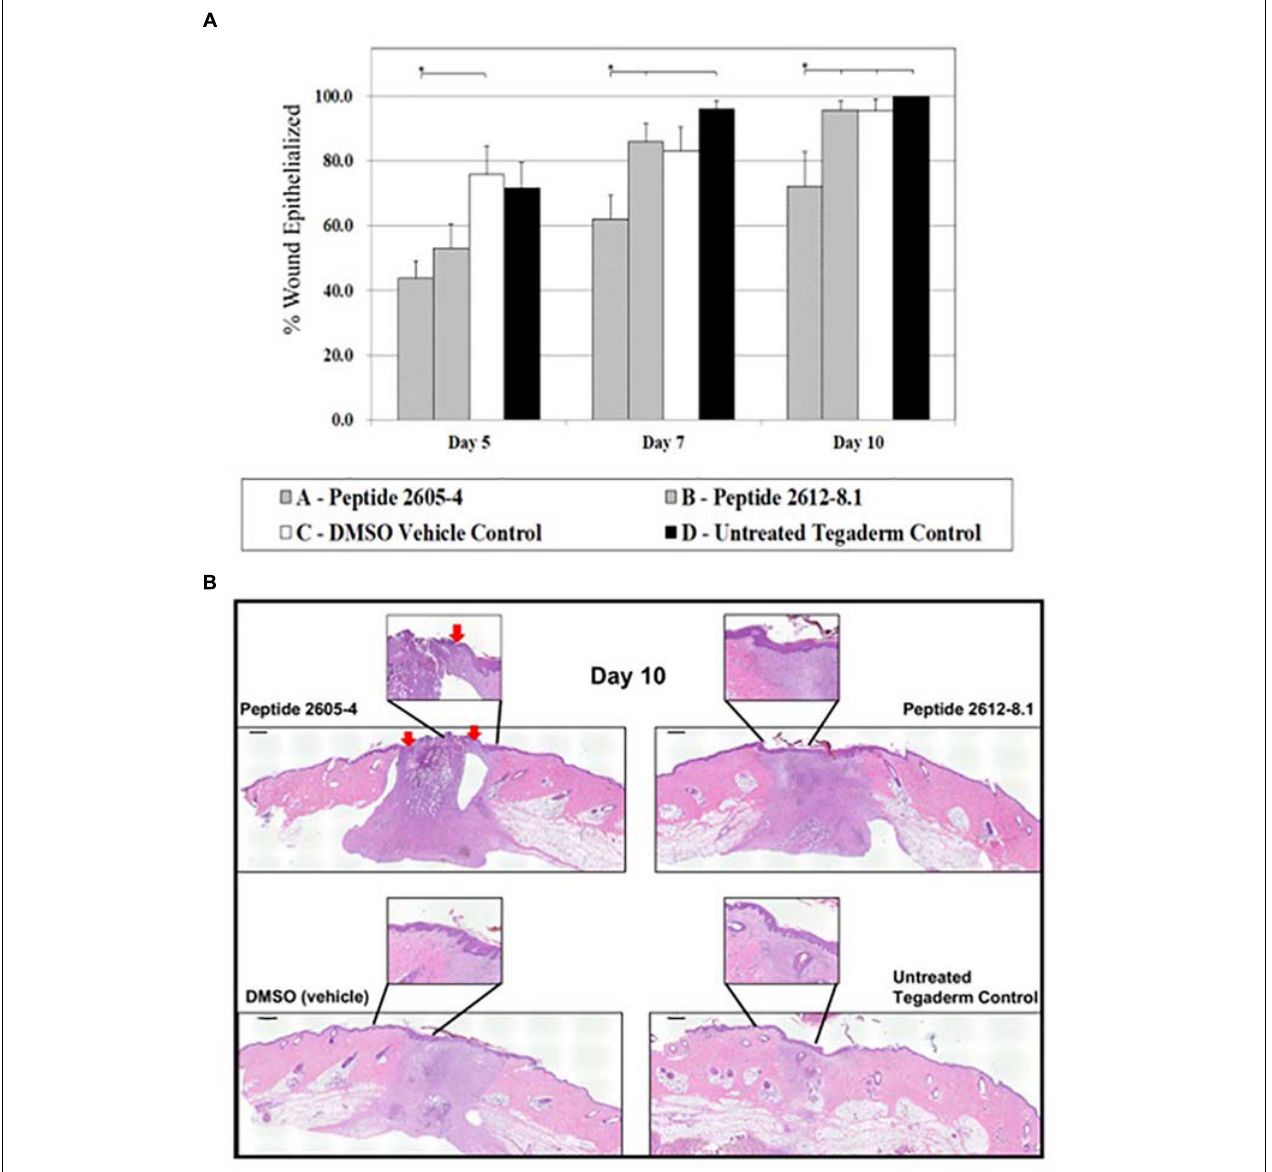
FIGURE 4 | CLP 2605-4 treatment inhibited wound closure. (A) Graph showing percentage of epithelialization for all treatment groups at days 5, 7, and 10 post-treatment. The amount of re-epithelialized tissue was calculated as a percentage of the wounded area that was covered by newly formed epidermis. Treatment with CLP 2605-4 resulted in inhibition of epithelialization compared to other treatment groups (* p ≤ 0.05). (B) Representative wounds at day 10 stained with H&E are shown. Red arrows indicate extent of wound edges in CLP 2605-4 treated wounds indicating wound gap. Enlargements show epidermis fully covering wounds treated with CLP 2612-8.1, vehicle and untreated control wounds. Scale bar = 1000 µ